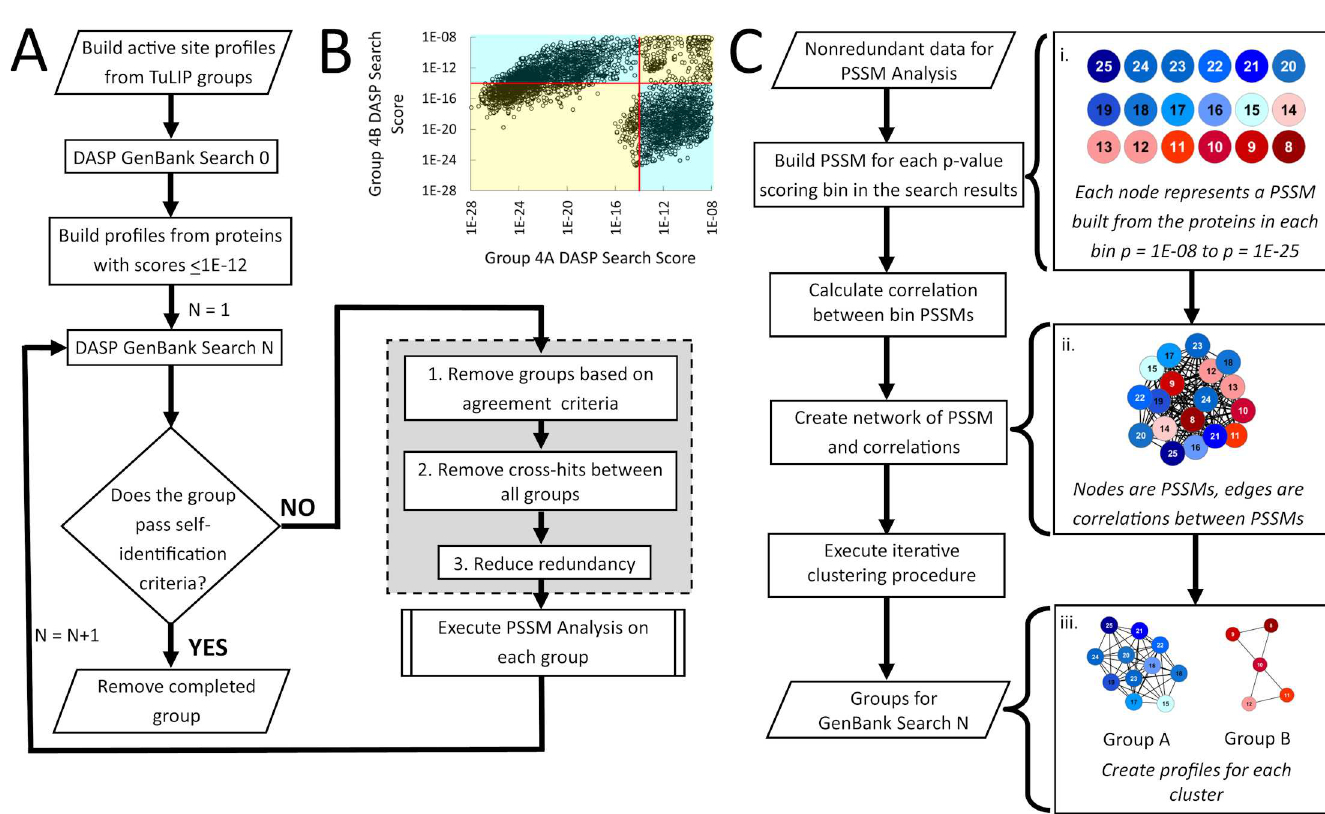
Fig 4. MISST and PSSM Analysis flowcharts describe the process of agglomerative identification of sequences as membersof functionally relevant groups. (A) Flow chart of the MISST process for identifying functionally relevant groupswithin a protein superfamily. (B) An illustration of the agreement criterion: a scatterplot of all proteins identified by DASP2 searchesusing two ASPs, Group 4A and Group 4B, that were subdivided in the previousMISST iteration.Red lines indicate the significancethreshold used to label proteins as “significant” or “not significant”in each group. Sequences in the yellow quadrantsare those identifiedin both searchesat similar (significant or not) DASP2 scores. Those sequencesin the cyan quadrants differ in significance. This metric is used to determineif a group that is subdivided by PSSM Analysis produces truly distinct search results. (C) Flow chart of PSSM Analysis for identifying when and how to divide clusters into functionallyrelevant